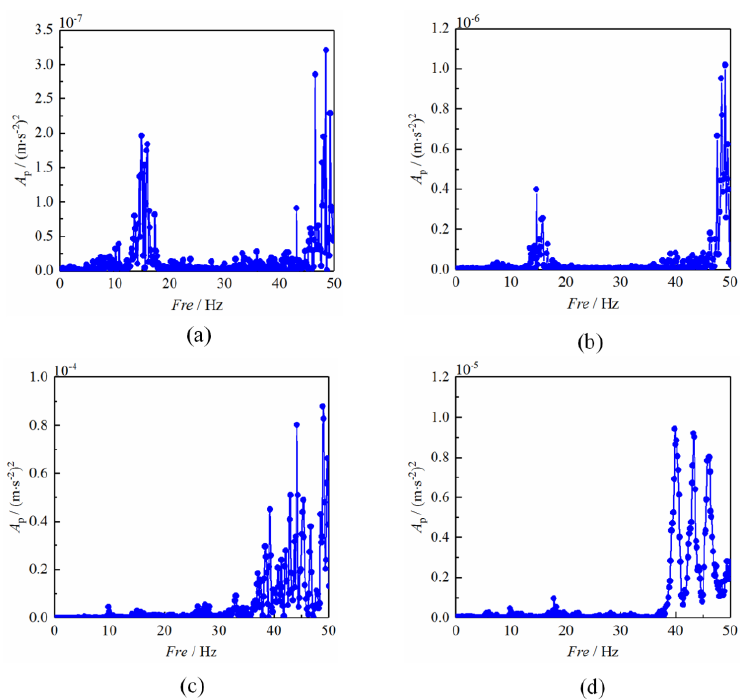
Figure 12. Power spectrum under different drainage states. ( a ) Single water phase, ( b ) Oil–water two-phase, ( c ) Gas–oil–water mixing phase, ( d ) Single gas phase.